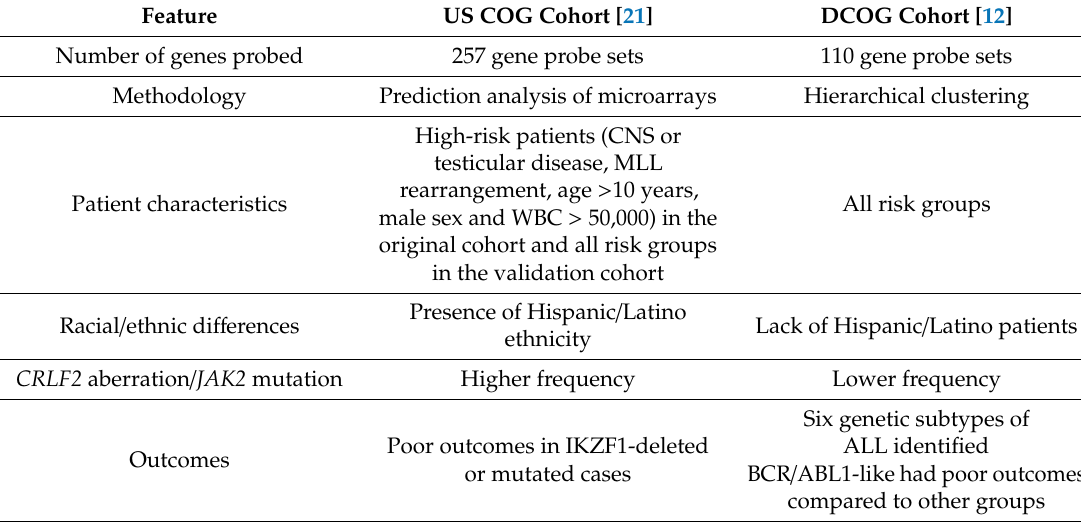
Table 1. Di ff erences between the cohorts and methodologies used in the initial description of Philadelphia (Ph)-like B-ALL